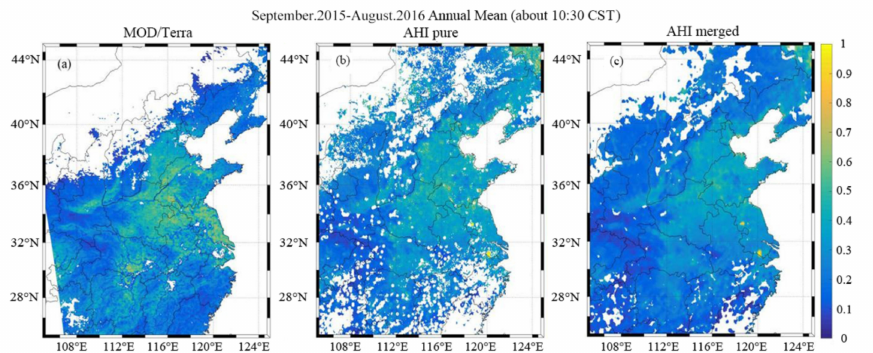
Figure 7. The AOT annual mean spatial distribution of three datasets at about 10:30 a.m. China Standard Time (CST). ( a ) MOD04 3 km AOT dataset at about 10:30 a.m. CST; ( b ) H8 / AHI AOT pure 5 km dataset;